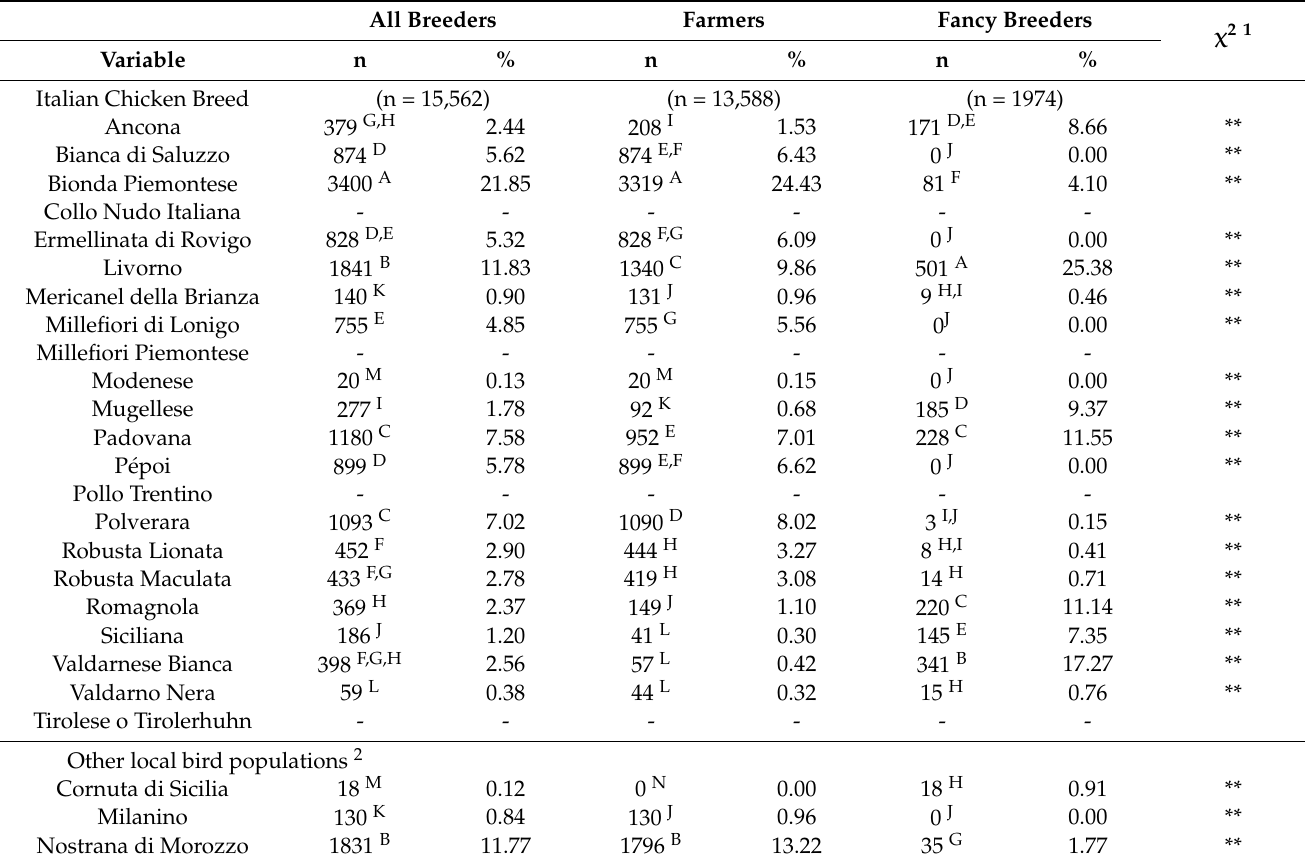
1 Chi square test for a single variable between the two breeder categories, i.e., within row comparisons; significance levels: ** p < 0.01. A–N Observations with different superscripts within the column are significantly different ( χ 2 -test p < 0.01). 2 Breeds not recognized by the Italian Ministry for Agricultural